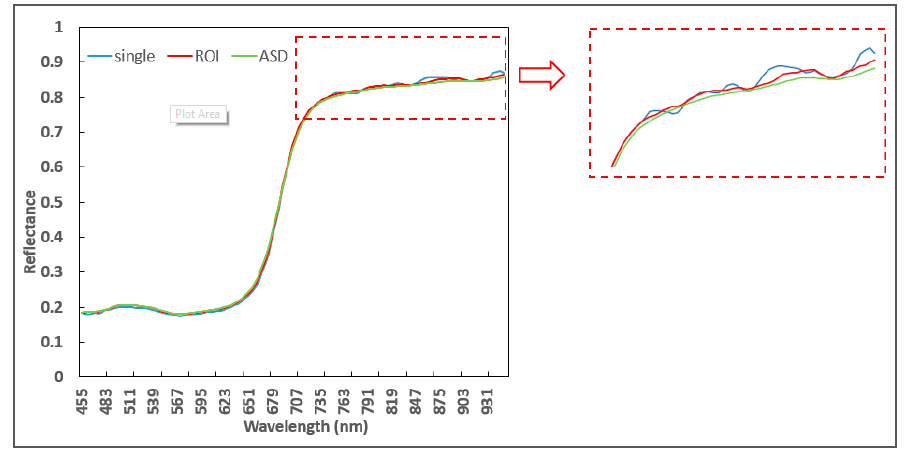
Figure 14. Spectra of vegetation. “Single” stands for the spectrum for a single pixel; “ROI” is the mean spectrum of ROI.